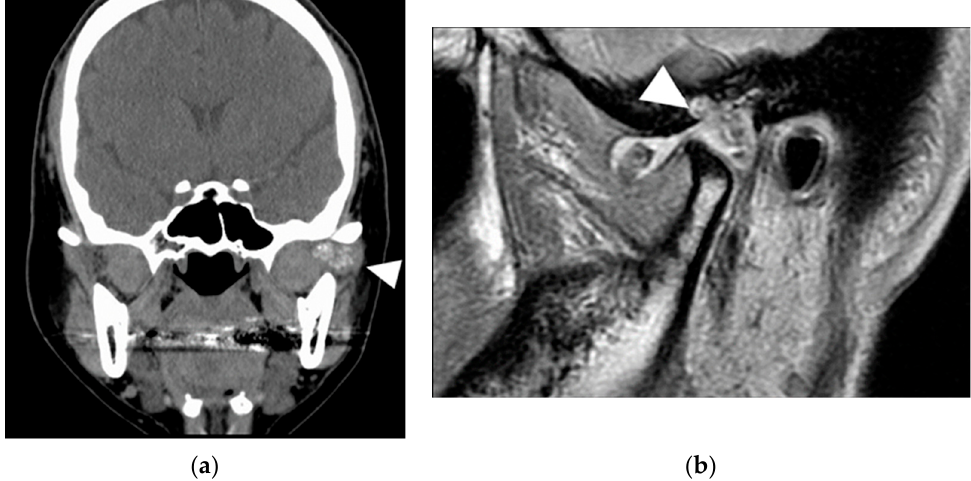
Figure 6. Imaging results in patient 2. ( a ) Computed tomography. Anterior and posterior deflection of the joint head is observed, with temporal bone resorption and perforation of the cranium. ( b ) Magnetic resonance imaging. A tumor similar to that detected on computed tomography is observed. Although it is in contact with the dura in the upper part, no progression to the brain parenchyma is seen. White arrows indicate lesions.